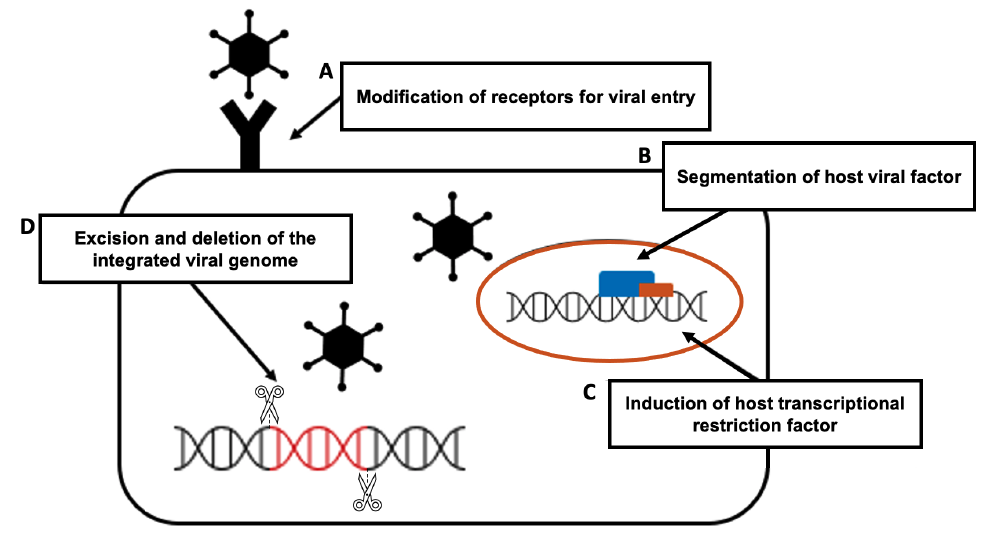
Figure 3. Mechanisms for preventing viral infection using the CRISPR-Cas system: ( A ) the modifica- tion of viral entry receptors by CRISPR-Cas-induced receptor gene editing; ( B ) the segmentation of host viral factors by the CRISPR-Cas-induced knockdown of proteins fundamental to viruses; ( C ) the induction of host transcriptional restriction by coupling inactive Cas and viral RNA; ( D ) the excision and deletion of integrated viral DNA by the CRISPR-Cas